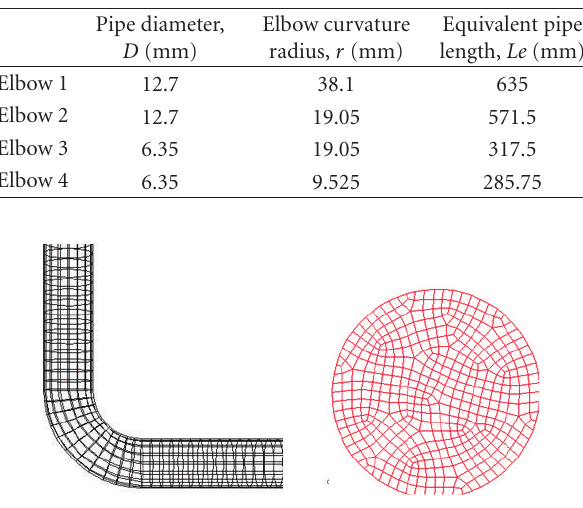
Figure 1: Elbow mesh with inlet